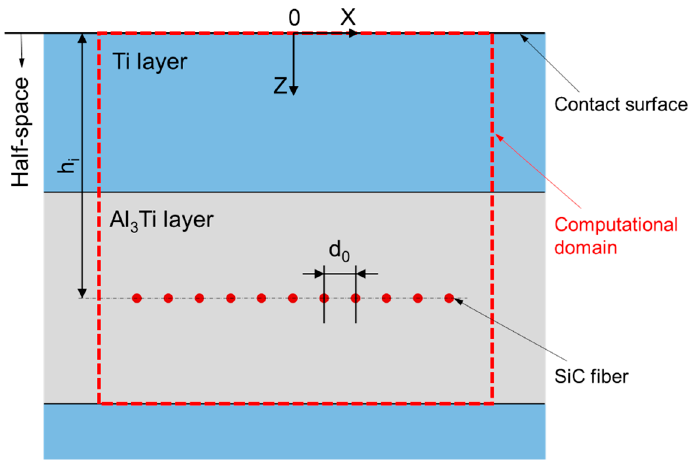
Figure 15. XOZ cross section of 3-D SAM model for validation. Table 3. Parameters of the new NEIM-based SAM model in validation.